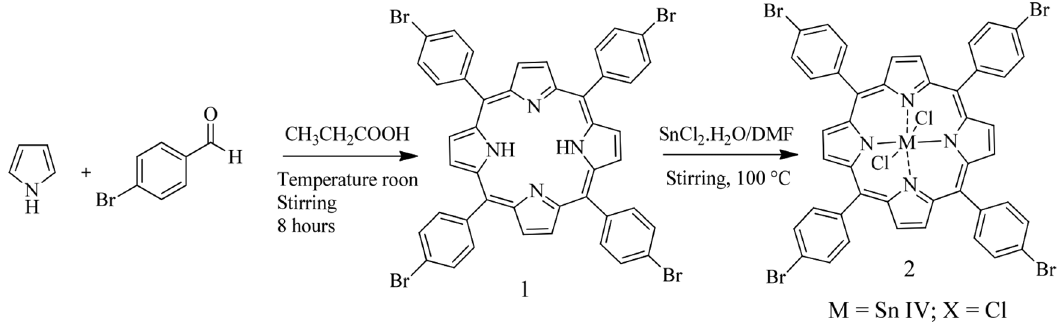
Figure 1. Synthesis route of compounds ( 1 ) and ( 2